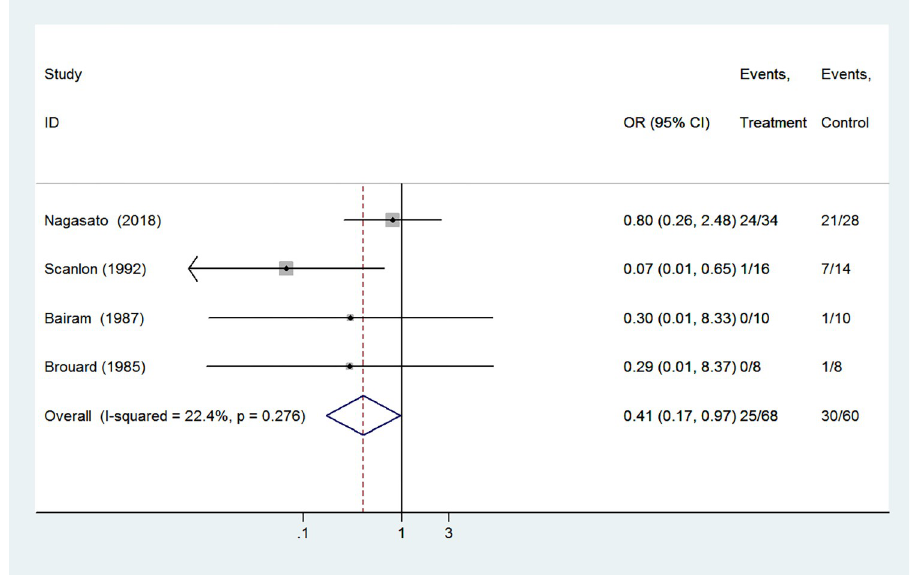
Fig 6. Forest plot of showing the effects of caffeine vs aminophylline on total adverse effects.